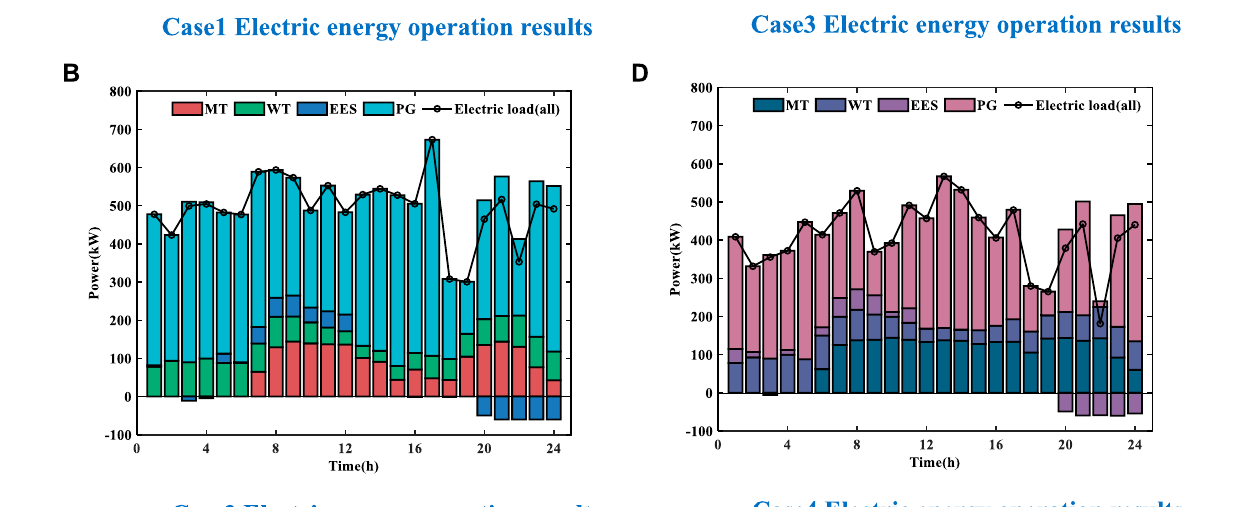
Frontiers in Energy Research |